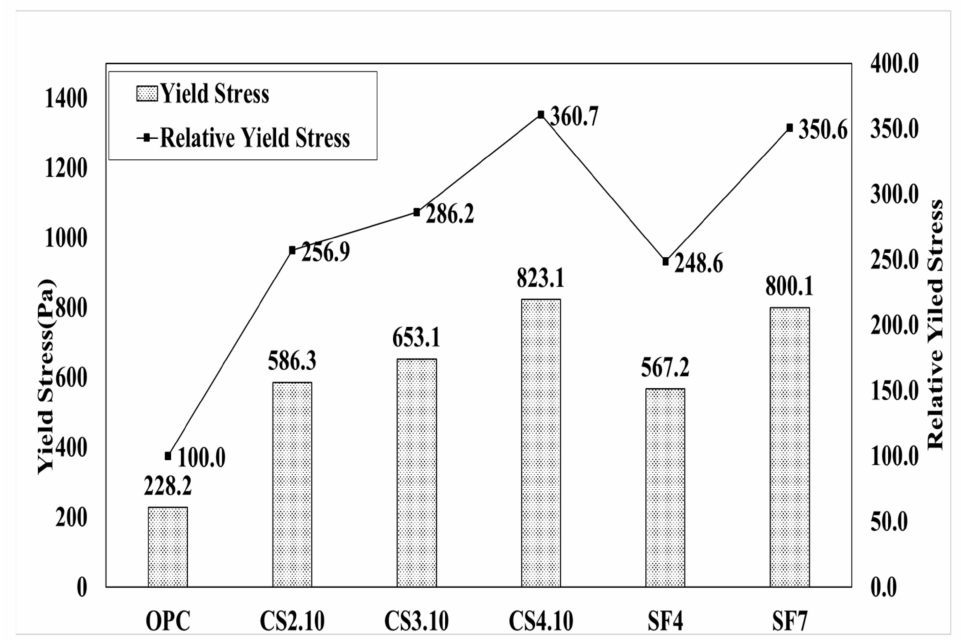
Figure 14. Yield stress ( τ 0 ) of the mixing